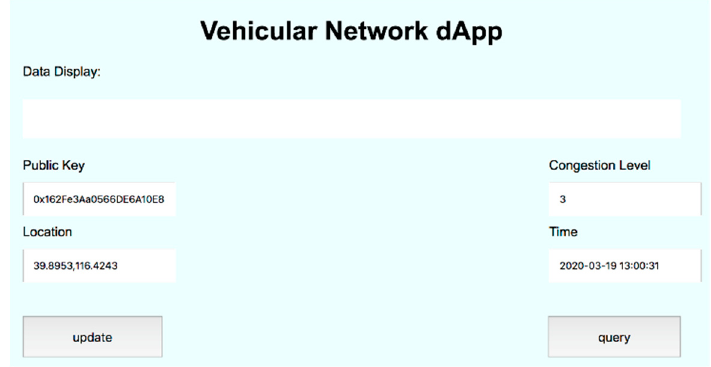
Figure 7. Vehicles can use dApp to query and upload data.